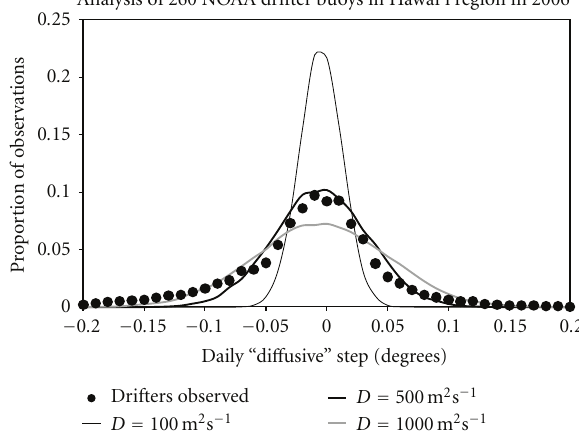
Figure 2: Daily di ff usive spatial steps aggregated across latitude and longitude observed from 260 NOAA drifter buoys in 2006 (symbols) and predicted from di ff usivity values of 100 m 2 s − 1 (thin line), 500 m 2 s − 1 (thick black line), and 1000 m 2 s − 1 (thick gray line). Lower values of di ff usivity cause particles to disperse less about the mean flow field trajectory, whereas high values of di ff usivity cause particles to disperse widely about the mean flow field